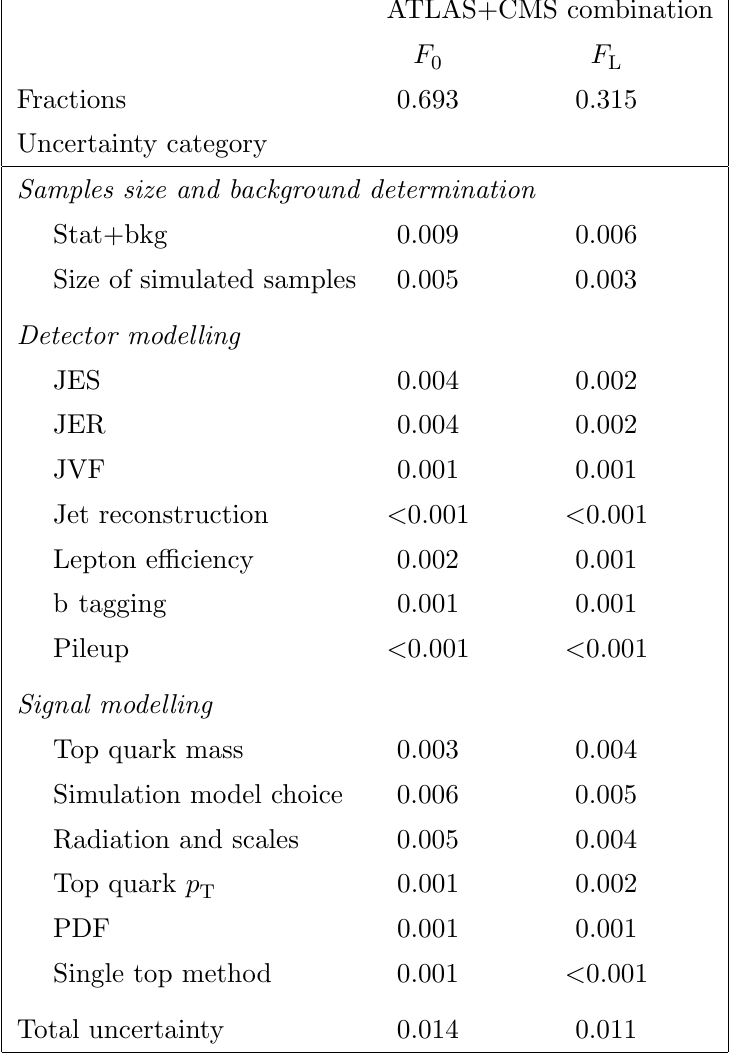
Table 7 . Results of the ATLAS and CMS combination: W boson polarization fraction values and uncertainties. The combined F and F values are anticorrelated, with (cid:26) = (cid:0) 0 : 85. 0 L This group of correlations is denoted in this document as (cid:26)